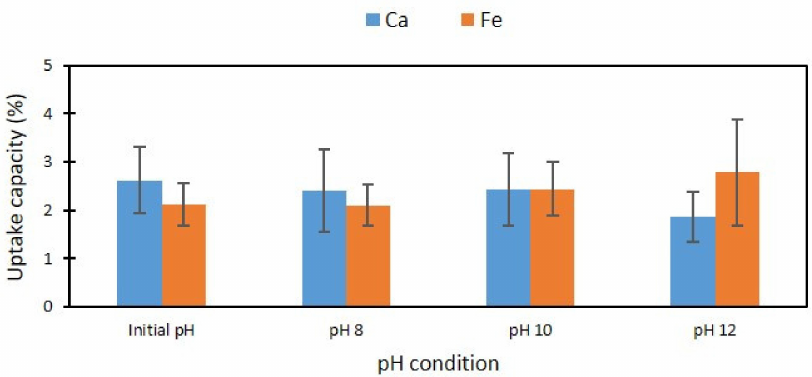
Figure 6. Average uptake capacity (%) for different pH conditions of Fe-rich mine waste. Error bars represent standard error of the mean (SEM).